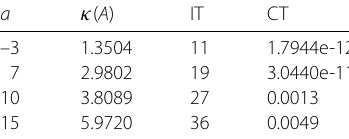
Table 3 Condition number, iteration time (IT), and CT for Ex.